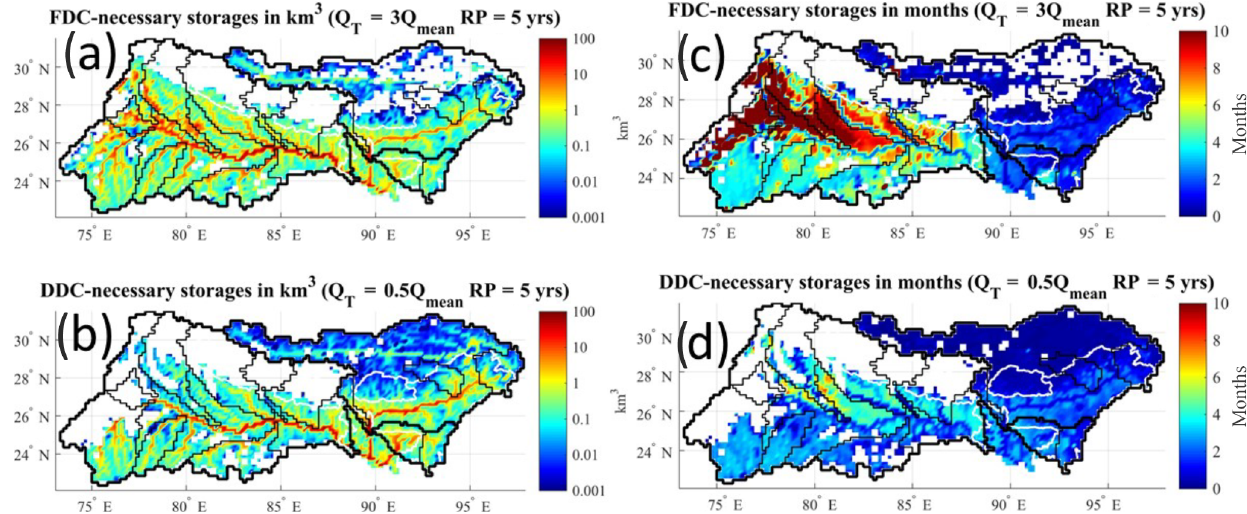
Figure 11. Necessary storages (a, b) in km 3 and (c, d) in months (a, c) for flood and (b, d) for drought management to maintain Q T = 3 Q mean during flood and Q T = 0.5 Q mean during drought of a return period of 5 years. The simulated discharge was for 1980–2001.